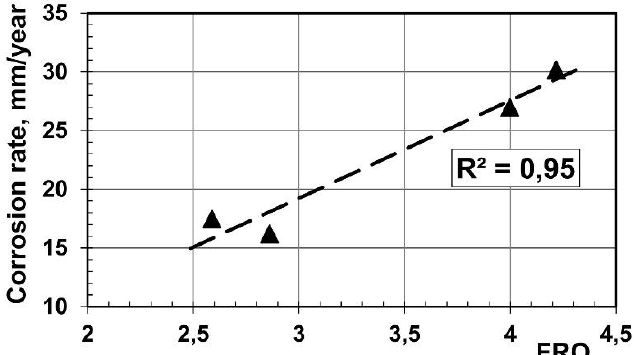
Figure 12. A correlation between the (10.0) pole figure ’ s maximum and the rate of